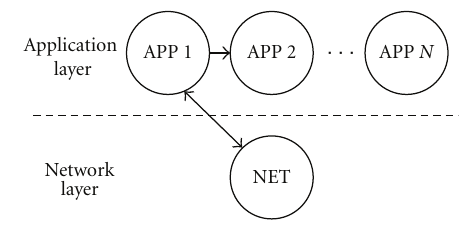
Figure 9: HeMPS software structure.